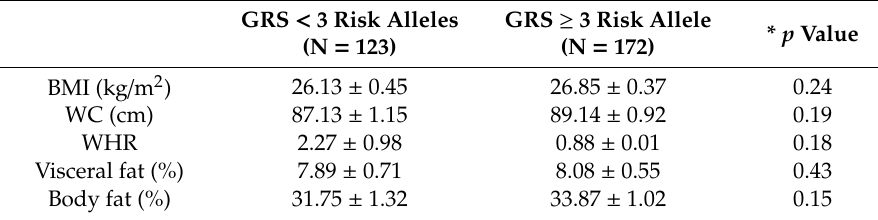
Table 2. Associations of the 4-SNP GRS on obesity-related traits.